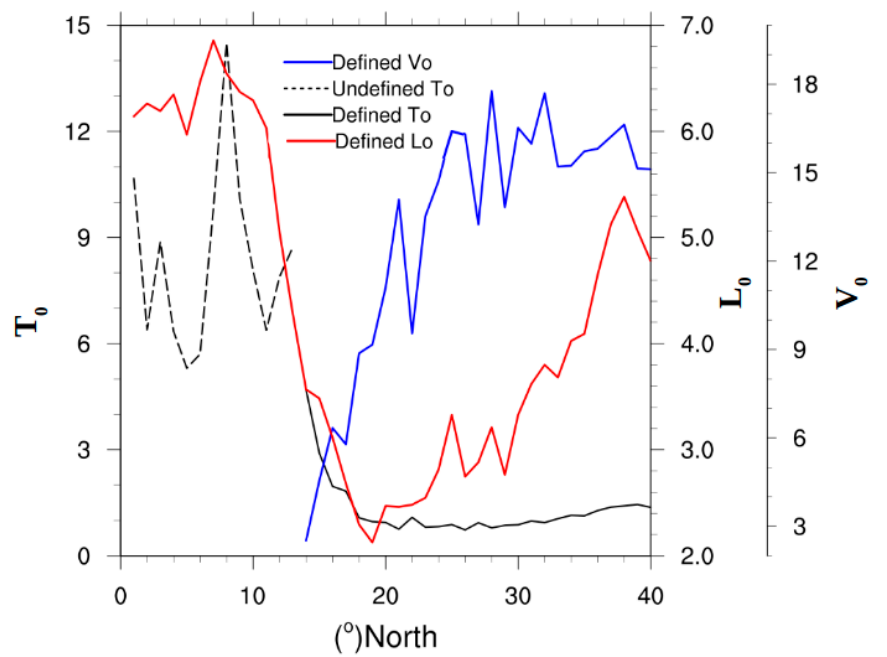
Figure 6. Variation of the characteristic length ( L 0 in red, in degree), of the characteristic duration ( T 0 in black at the right, in days) and of the characteristic speed ( V 0 = L 0 / T 0 in blue, in km · h − 1 ) as a function of the latitude from 0 to 40 ◦ N. The black solid line indicates the latitudes where exponential law is defined for duration and dashed line latitudes where it is not defined.